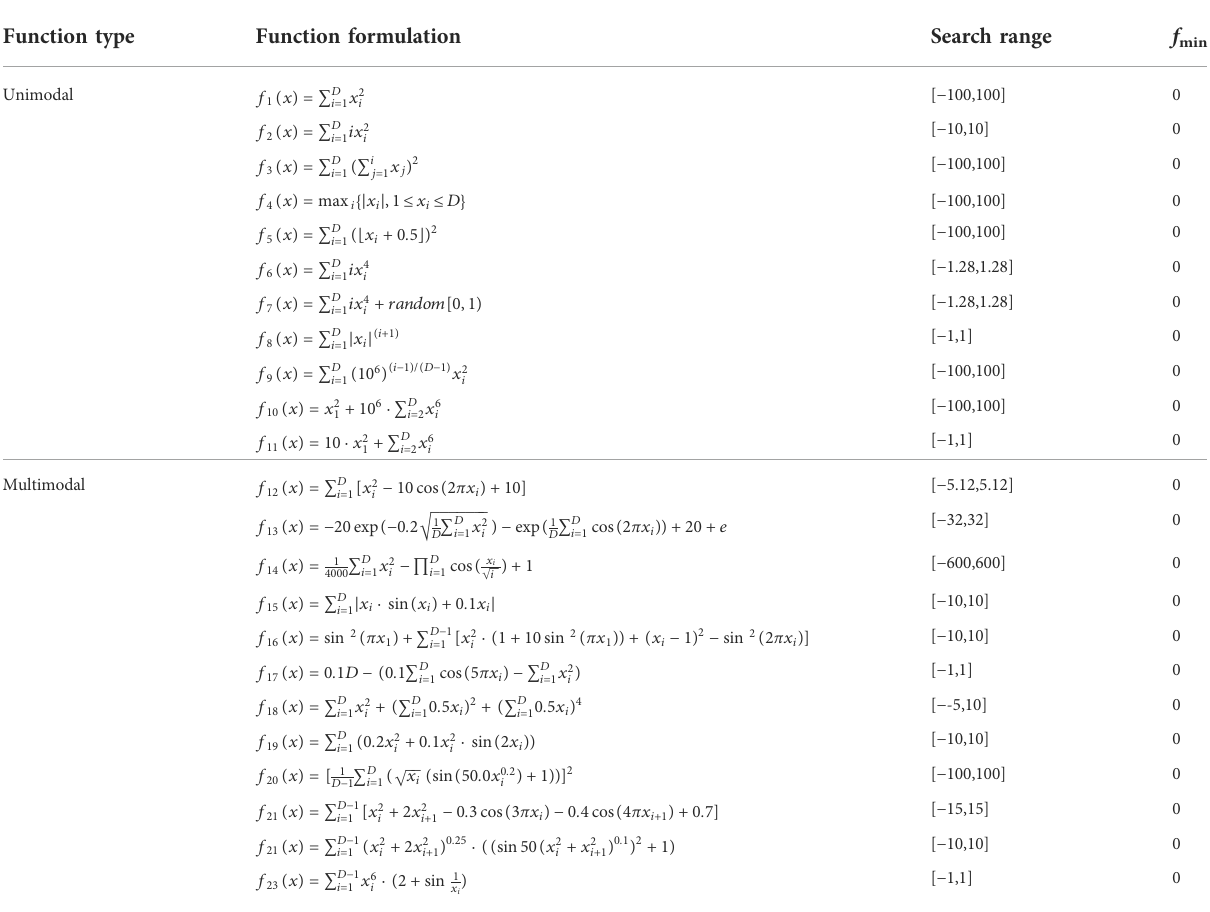
FIGURE 4 The fl ow chart of OPLSSA.